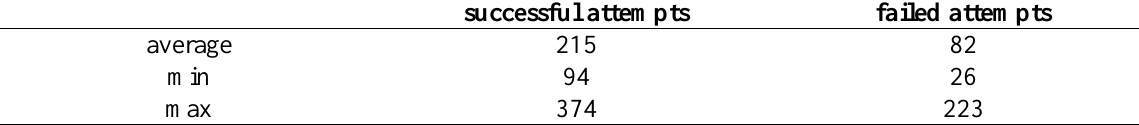
Table 3. Number of flakes resulting from successful and failed attempts to make an experimental tool successful